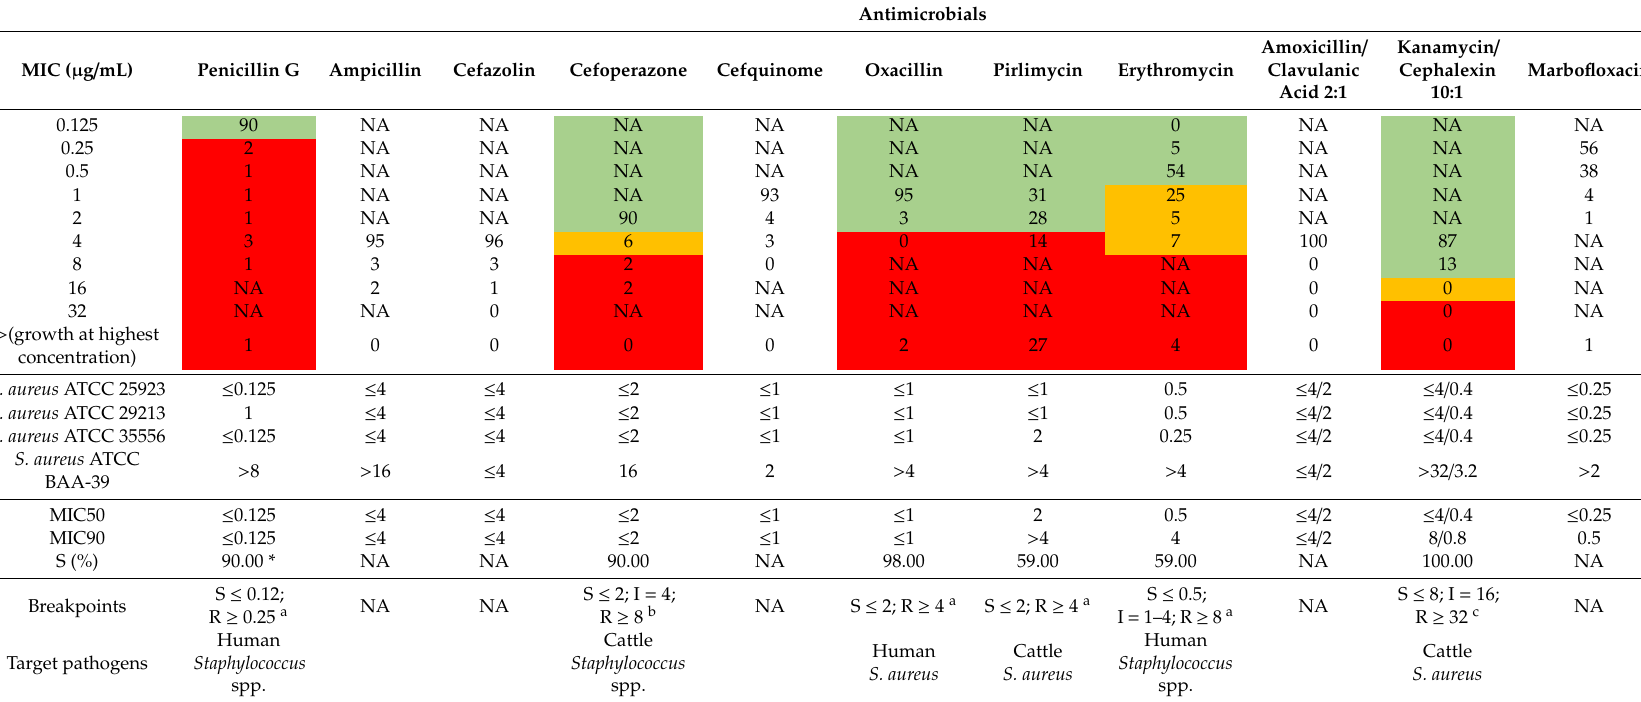
Table 2. Minimal inhibitory concentration of Staphylococcus aureus ( n = 100) isolated from bovine mastitis in